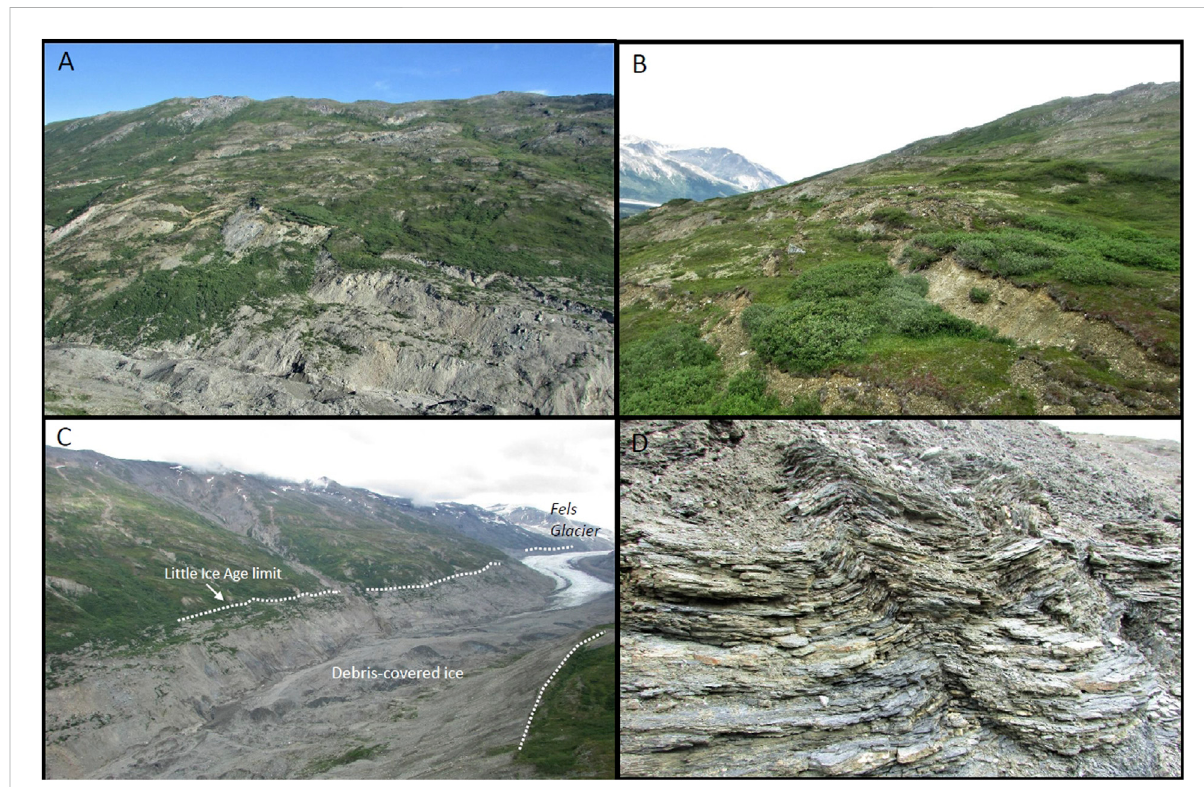
FIGURE 1 Photographs fromstudy area. (A) view ofFelsslidetowardthenorth,showingslumping near thetoeofFels Glacier.The glacier toeislocated at theextremebottom-leftcornerofthephoto. (B) .Close-up viewofslumpblocksinFelsslide. (C) .FelsGlacierfromnearitstoe;viewtowardtheeast. Lateral moraines that mark theupper limit of theglacier inthe mid-1800s are marked bydotted white lines. (D) . Sericite schist, whichis typical ofthe bedrock in Fels valley. Foliation in the schist dips to the south, more-or-less parallel to the Fels slide